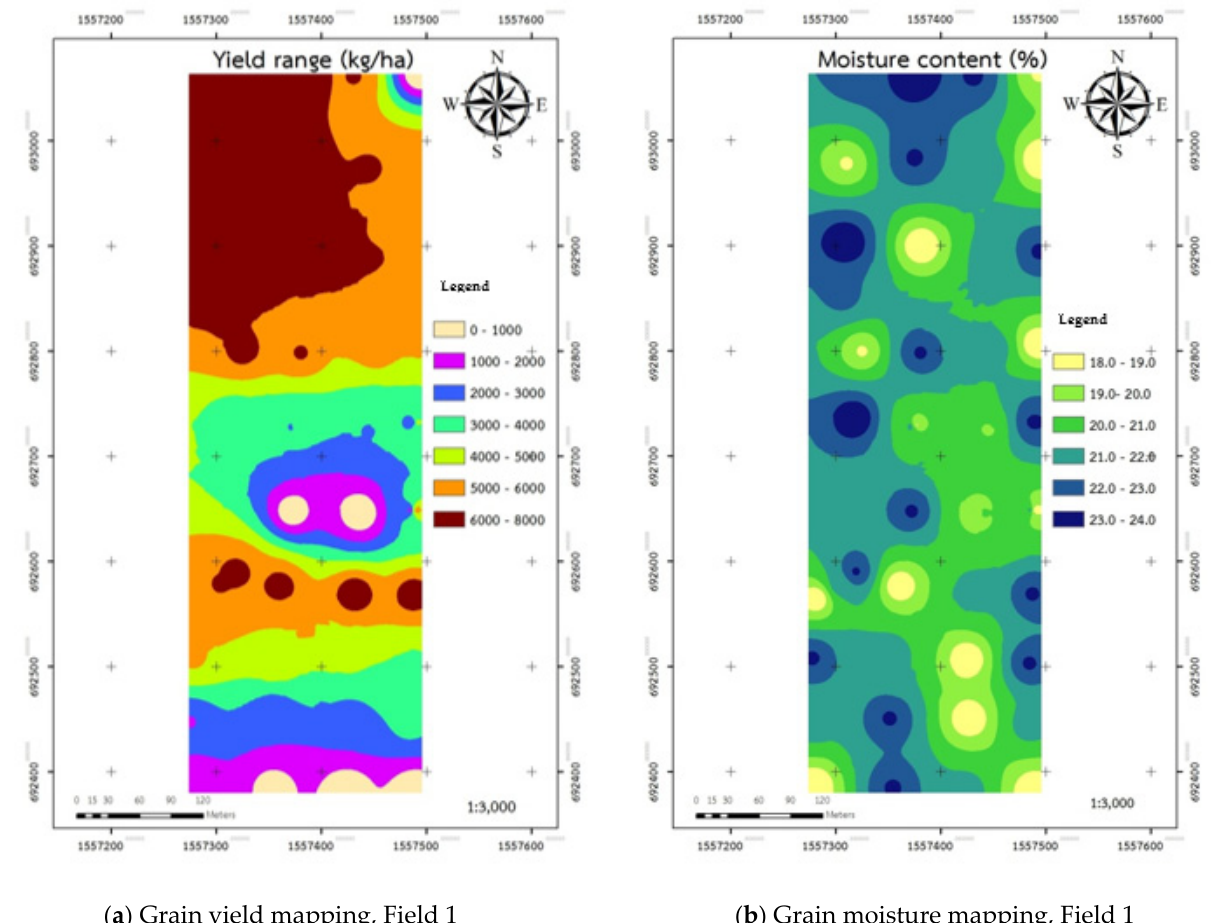
Figure 9. Yield and moisture content variation of plantation of 0.3 ha.